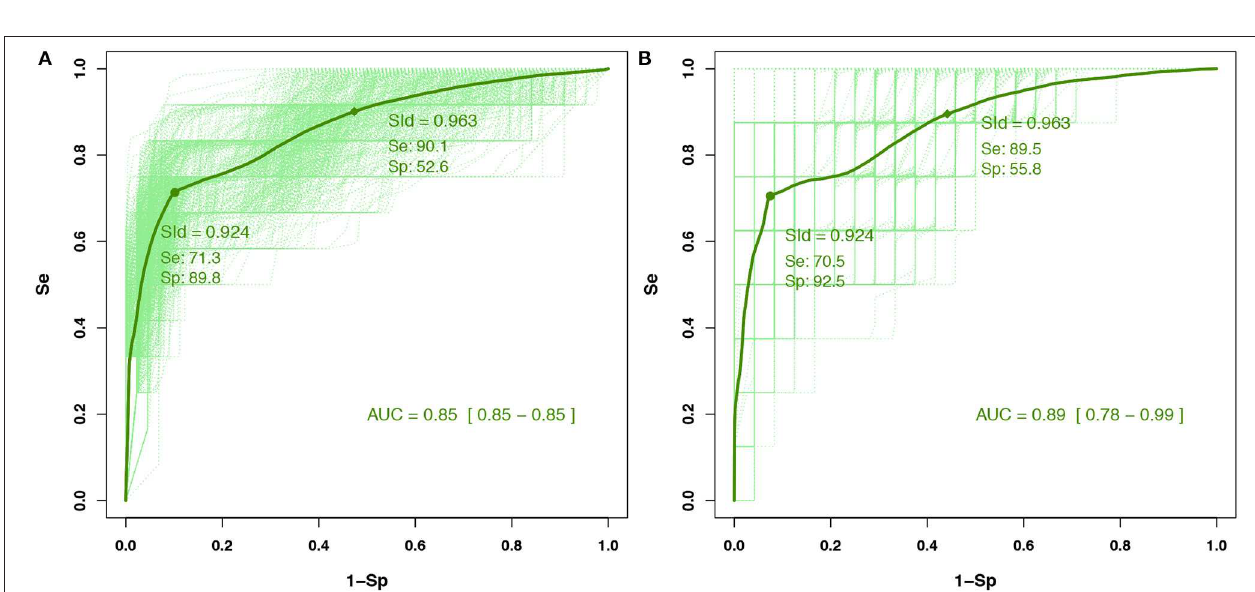
FIGURE 3 | Receiver operating characteristic (ROC) curves for (A) the training cohort involving 15 people with pMS and (B) the test cohort involving seven people with pMS for the IITD detection method. Cutoffs were determined with the training cohort, and their predictive values were computed within the test cohort. Dashed curves are ROC curves for each configuration of the Monte Carlo cross-validation (and the nested four-fold cross-validation for the training set). Plain curves are the means of all dashed curves.